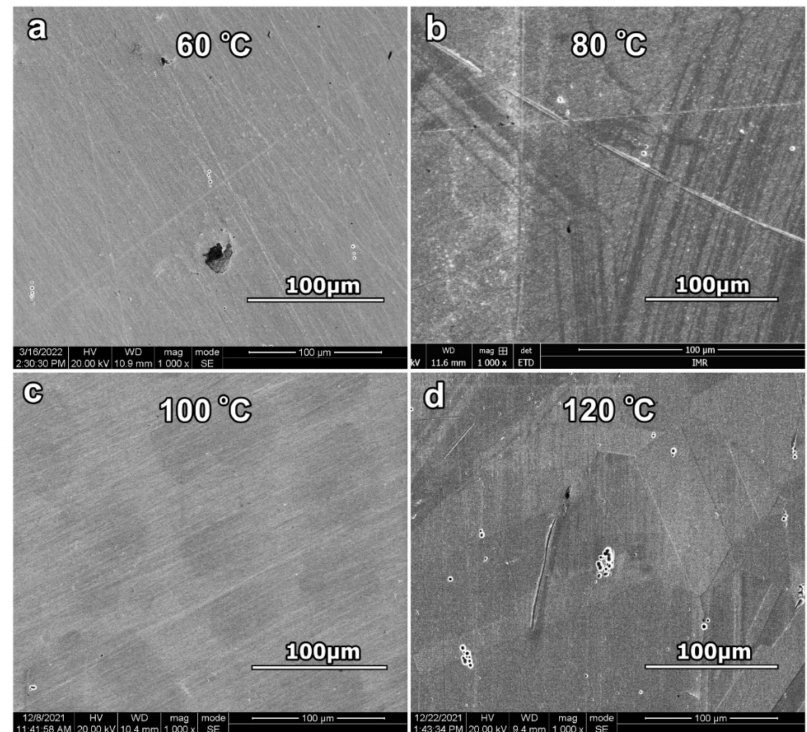
Figure 10. Morphologies of SiN stainless steel after corrosion in nitric acid vapor phase at different